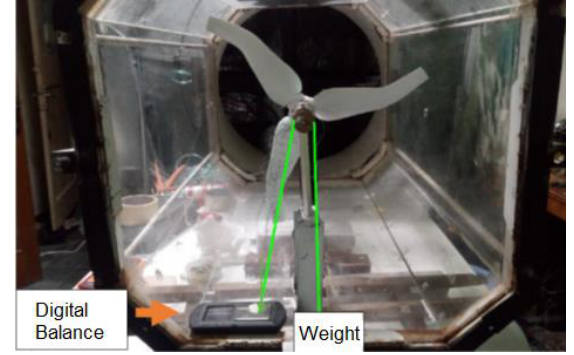
Figure 4. Test schematic in wind tunnel.